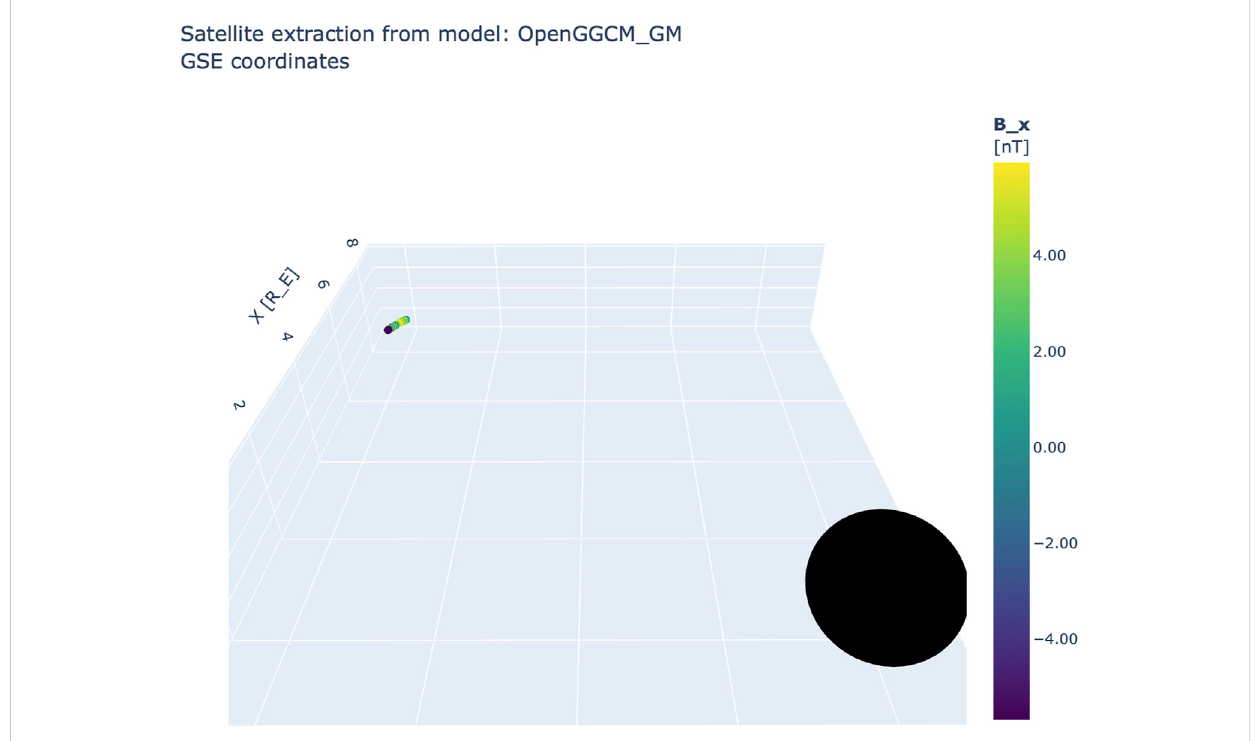
FIGURE 5 A screenshot of a 3D plot produced by the Kamodo fl ythrough.